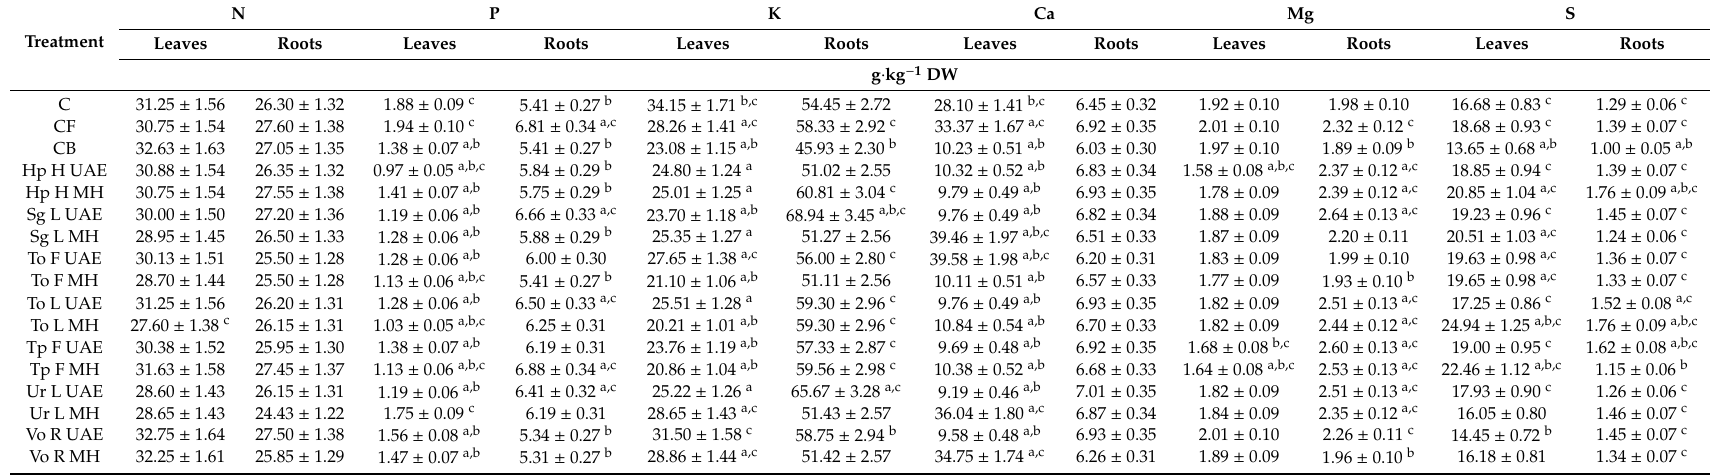
Table 3. E ff ect of the foliar application of botanical extracts on the macroelements content of celeriac leaves and roots (N = 3, mean ± SD).